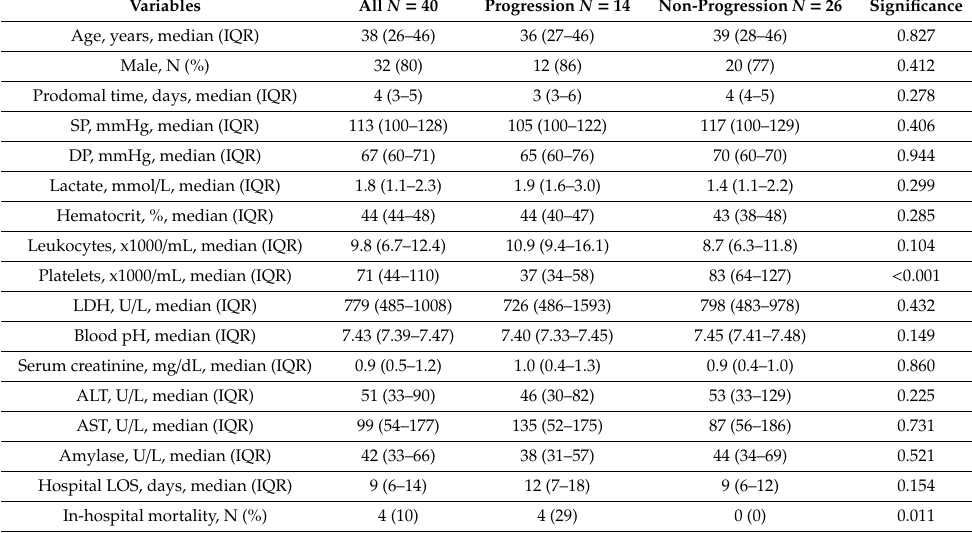
Table 2. Comparison of patients with progressive disease ( N = 14) versus non progressive disease (patients who remain as mild disease during hospital stay, N = 26). SP (systolic arterial pressure), DP (diastolic arterial pressure), P / F ratio (arterial oxygen partial pressure to inspired oxygen fraction ratio), LDH (lactate dehydrogenase), ALT (alanine aminotransferase), AST (aspartate aminotransferase), Hospital LOS (hospital length of stay). Prodromal time was defined as the number of days with fever before hospital admission. Only platelet count was di ff erent between both groups of patients (Mann Whitney U Test). Mortality was higher in patients with progressive disease (Fisher’s exact test).